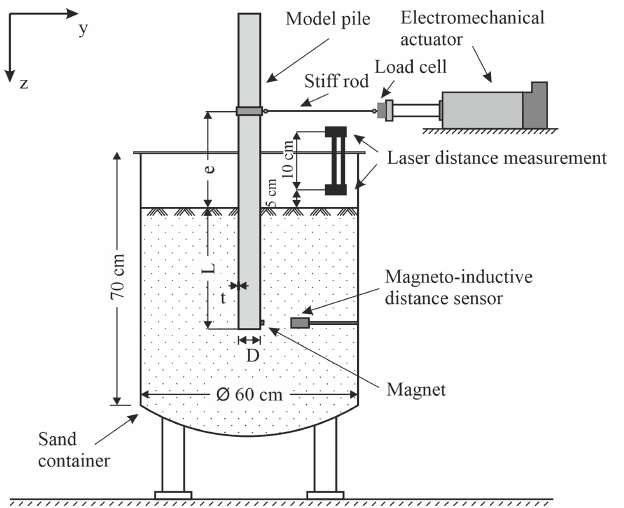
Figure 3. Schematic of experimental test